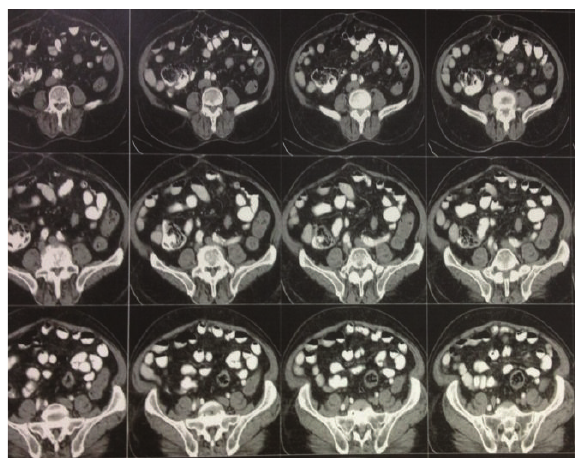
Figure 1: CT scan 5 months before surgery.